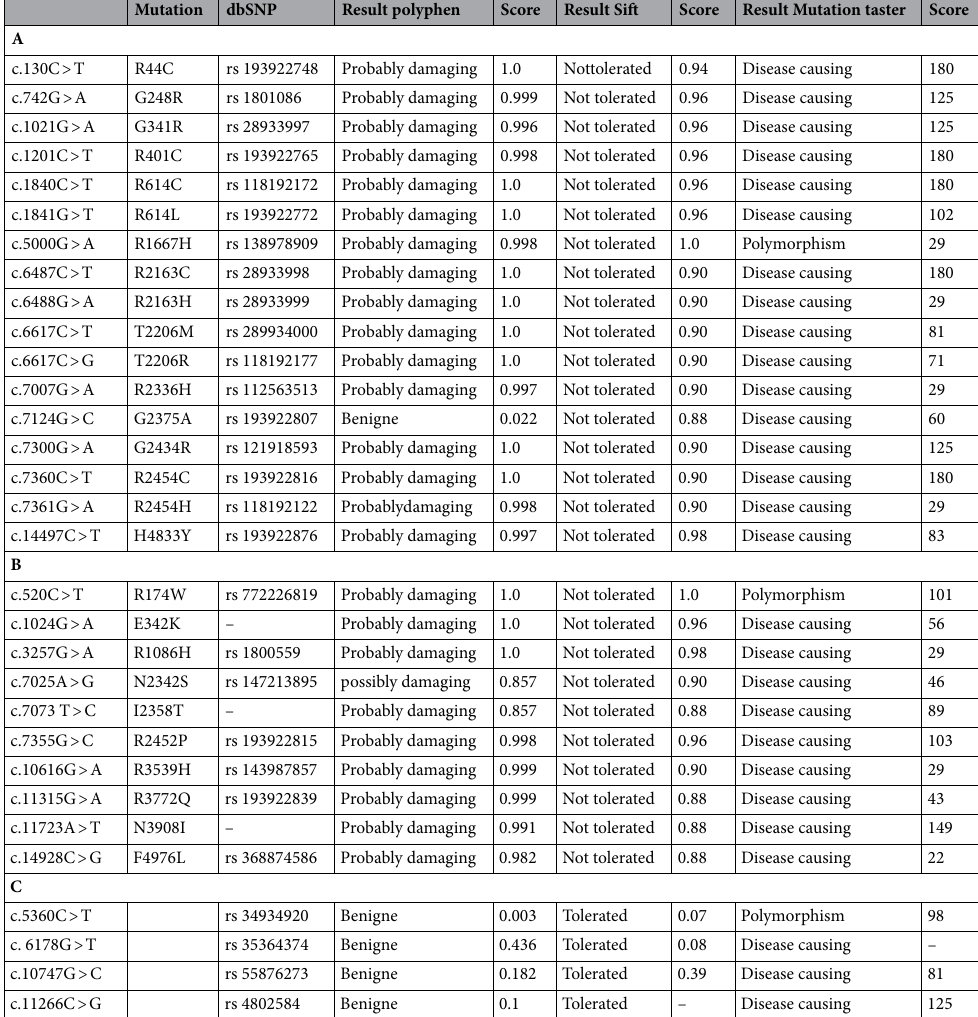
Table 2. In silico approach analysis (Polyphen-2, Sift, MutationTaster). (A) Diagnostic variants listed on the European Malignant Hyperthermia Group website, (B) Variants of unknown significance, (C) Four added benign